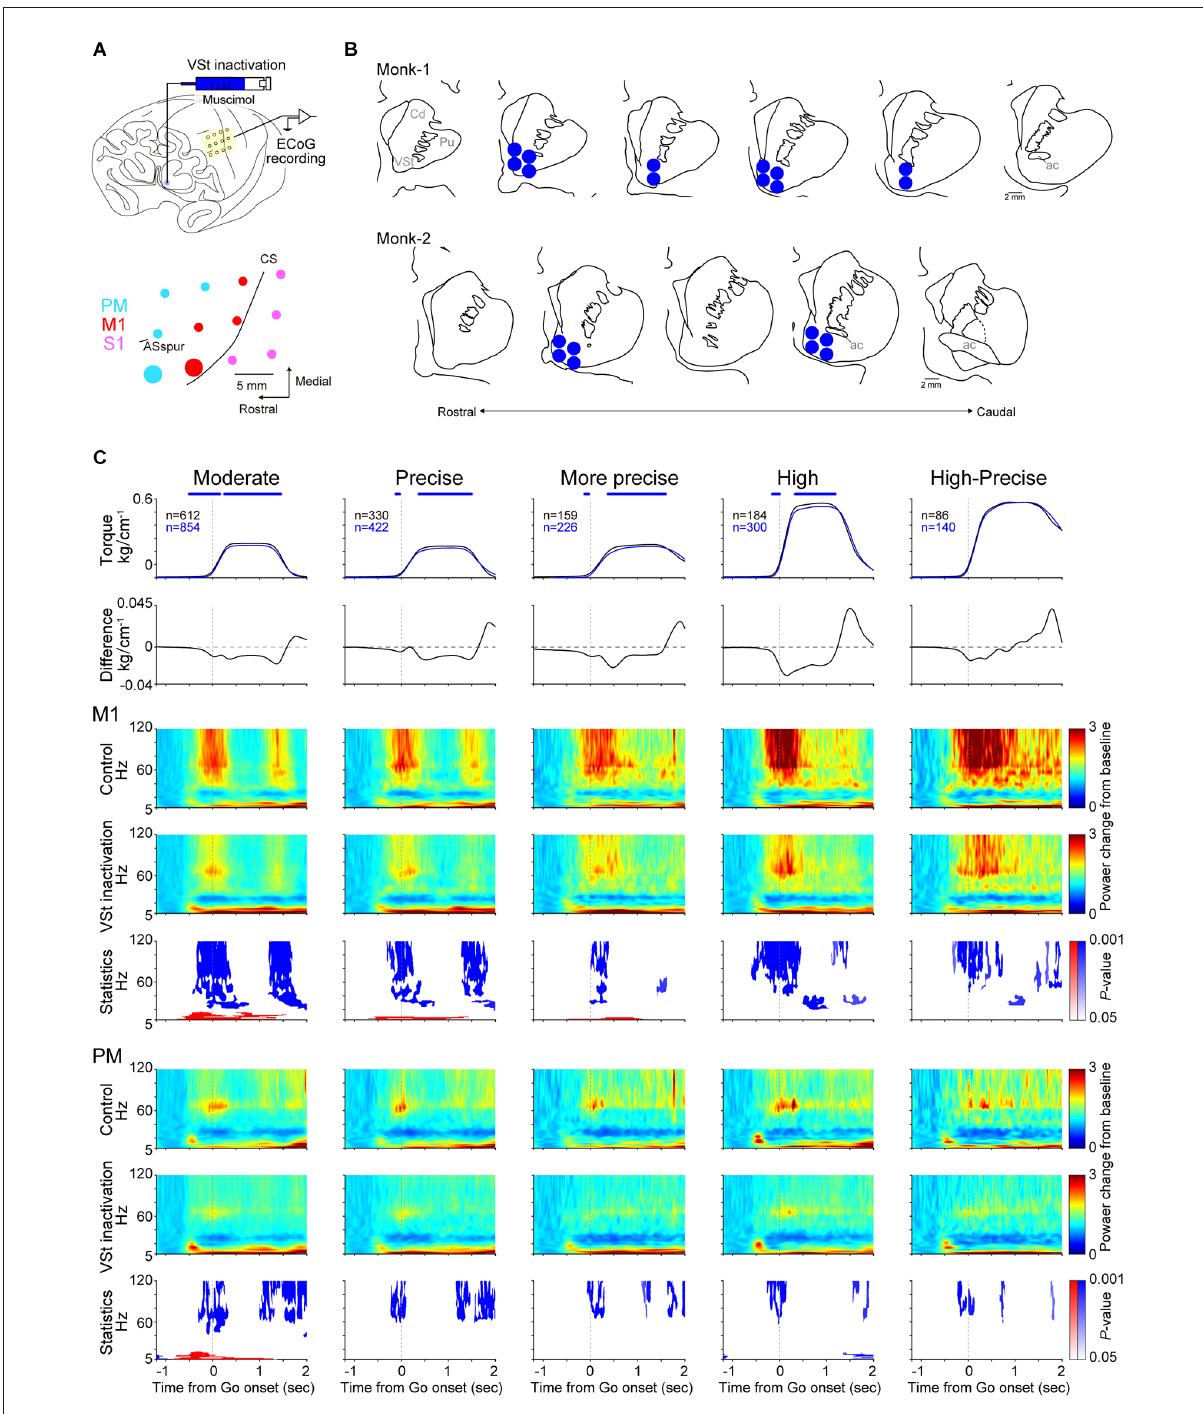
FIGURE2 VSt inactivation reduces torque output and movement-related activity. (A) Top: Scheme of VSt inactivation and simultaneous ECoG recording. Bottom: Recording sites on the PM, M1, and S1 are shown in cyan, red, and pink color, respectively. The electrode locations on the functional map were determined relative to anatomical landmarks such as the central sulcus and arcuate sulcus and the location of the electrode. The activity of typical examples in (C) was recorded from the enlarged red (M1) and cyan (PM) sites. Data obtained from Monk-1. CS, central sulcus; ASspur, spur of the arcuate sulcus. (B) Muscimol injection sites reconstructed from histological coronal sections in both monkeys. Each section interval is 1 mm. Cd, Caudate nucleus; Pu, Putamen. (C) Comparison of movement-related activity of a typical example in the M1 and PM between control and the VSt inactivation trials. First row: Averaged wrist torque trace (Control, black; VSt inactivation, blue).